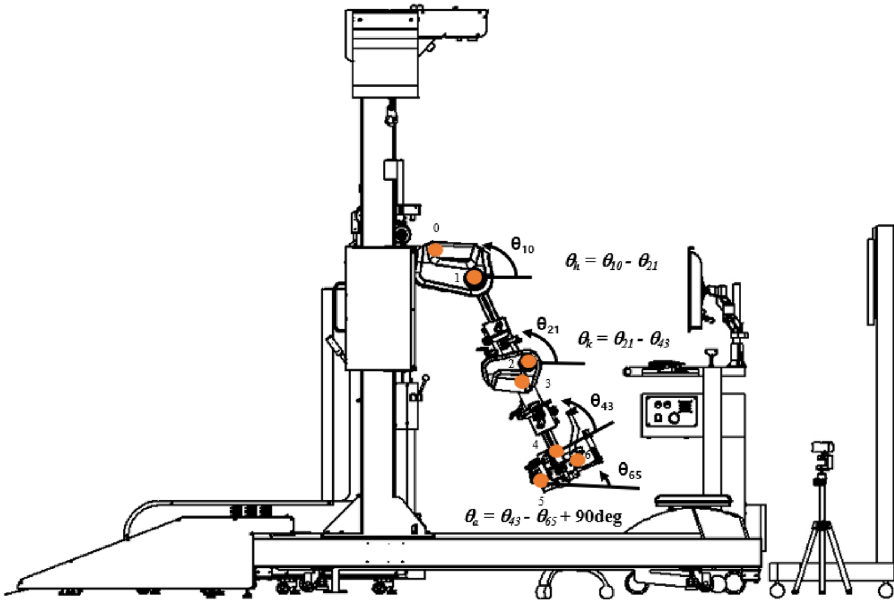
Figure 2. Lower-extremity kinematic joint angle calculation in ICT system. ICT innovative ankle–knee–hip interlimb coordinated humanoid